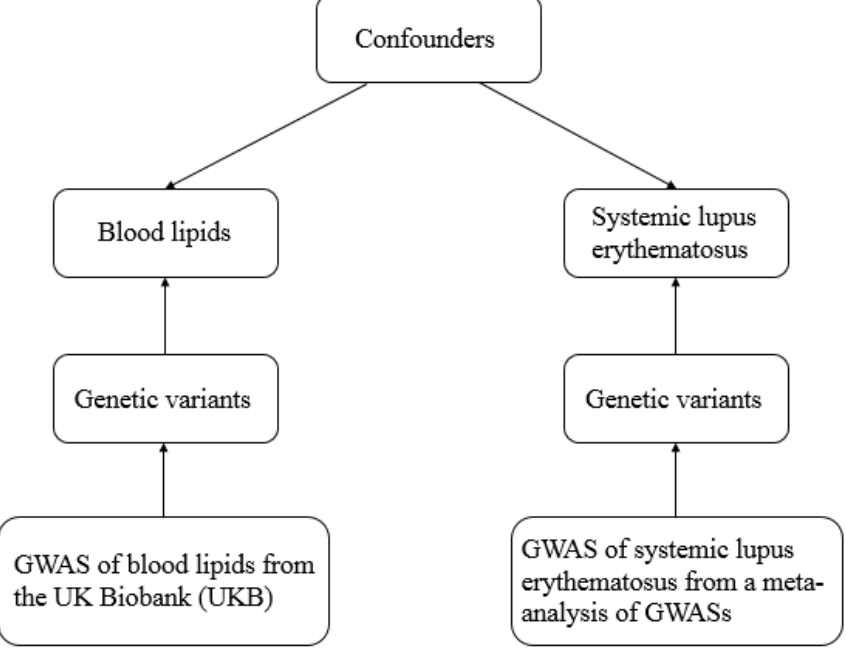
Figure 1. Workflow of two-sample MR for causal effect between blood lipid levels and SLE.